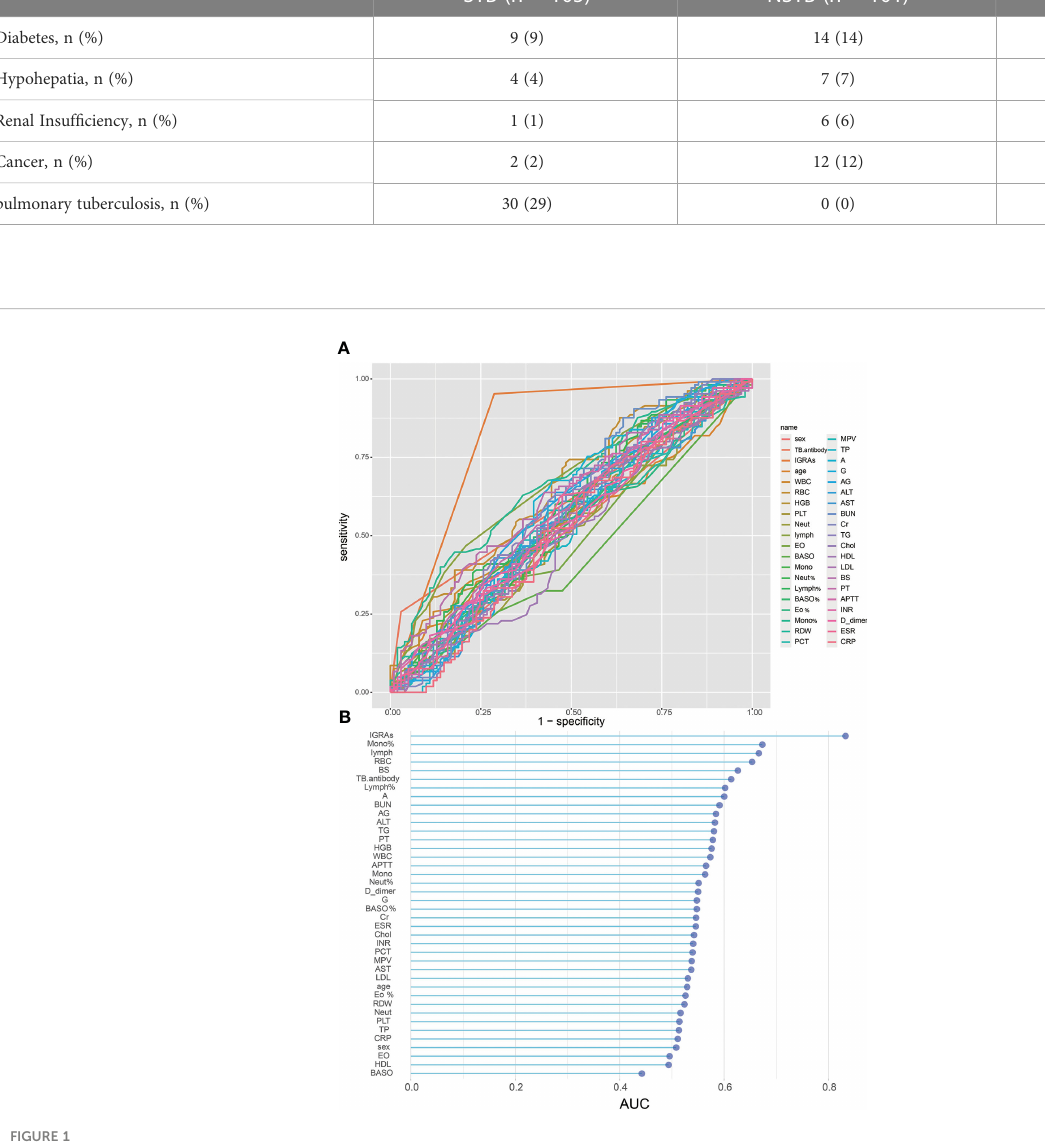
FIGURE 1 Single variable on STB diagnostic capability: (A) , ROC curve of single variable on STB diagnosis; (B) , AUC of single variables for STB